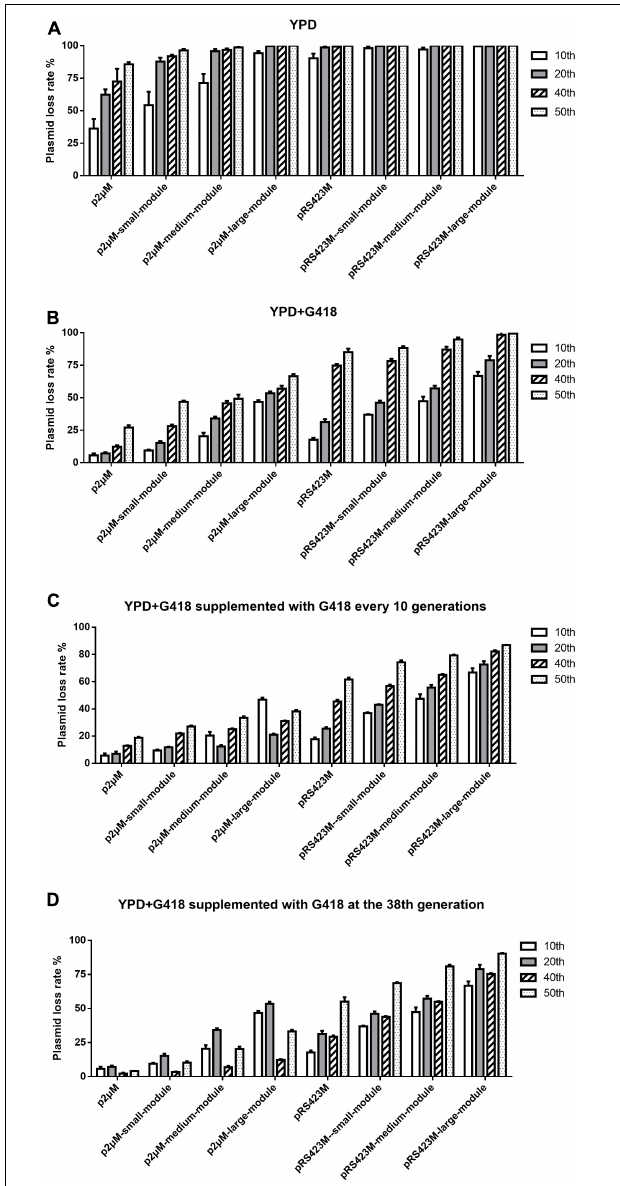
FIGURE 1 | Plasmid loss rates of the p2 µ M-based plasmids with different sizes of inserted fragments compared with that of pRS423M-based plasmids. (A) Plasmid loss rates of the p2 µ M-based plasmids and the pRS423M-based plasmids after cultivation in YPD medium. (B) Plasmid loss rates of the p2 µ M-based plasmids and the pRS423M-based plasmids after cultivation in YPD + G418 medium. (C) Plasmid loss rates of p2 µ M-based plasmids and pRS423M-based plasmids in YPD + G418 medium supplemented with G418 every 10 generations. (D) Plasmid loss rates of p2 µ M-based plasmids and pRS423M-based plasmids in YPD + G418 medium supplemented with G418 at the 38th generation.